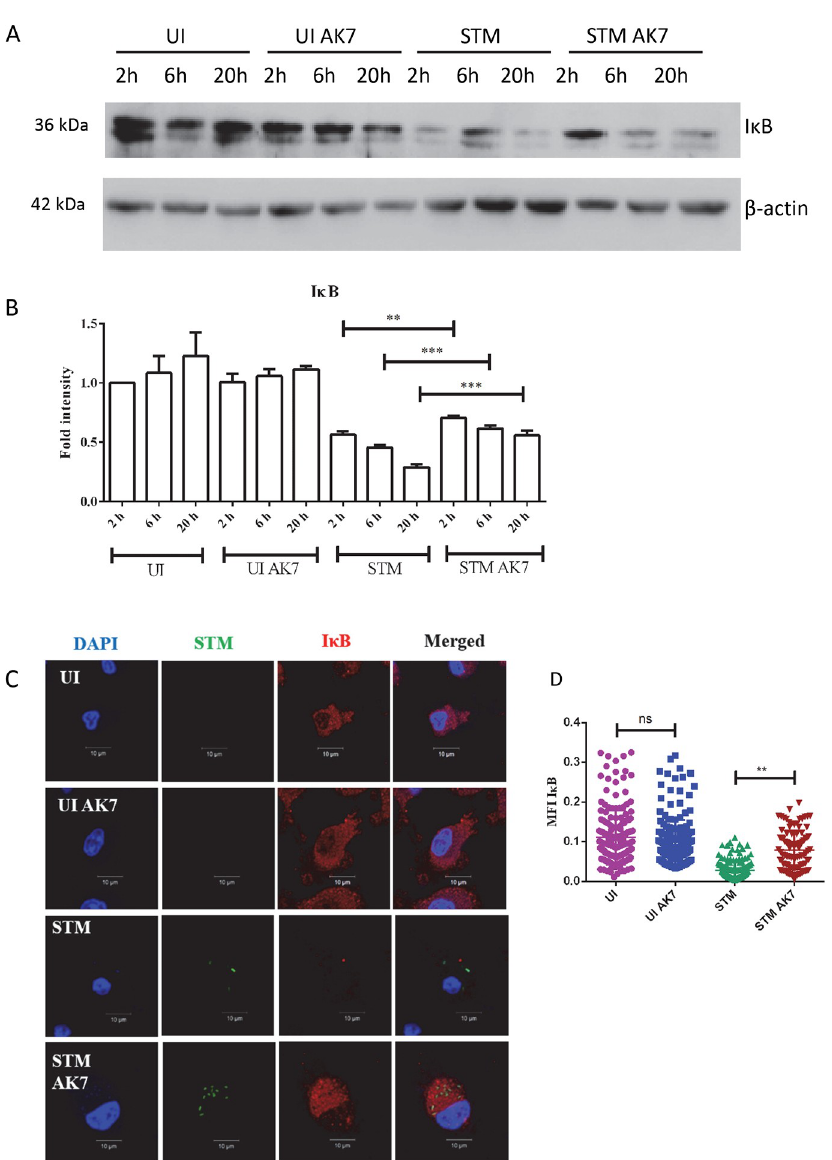
Fig 6. SIRT2 inhibition inhibits I κ B degradation. A. Representative immunoblot of I κ B in the presence and absence of SIRT2 inhibition at the indicated time point post infection. (UI- uninfected DCs, UI AK7- Uninfected DCs treated with 10 μ M AK7, STM- Salmonella Typhimurium infected DCs, STM AK7- Salmonella Typhimurium infected DCs treated with 10 μ M AK7). B. Densitometry analysis of I κ B immunoblot in the presence and absence of SIRT2 inhibition at the indicated time point post infection. (UI- uninfected DCs, UI AK7- Uninfected DCs treated with 10 μ M AK7, STM- Salmonella Typhimurium infected DCs, STM AK7- Salmonella Typhimurium infected DCs treated with 10 μ M AK7) (Data are presented as mean ± SEM of 3 independent experiments). C. Representative immunofluorescence image of I κ B in the presence and absence of SIRT2 inhibition at the indicated time point post infection. (UI- uninfected DCs, UI AK7- Uninfected DCs treated with 10 μ M AK7, STM- Salmonella Typhimurium infected DCs, STM AK7- Salmonella Typhimurium infected DCs treated with 10 μ M AK7) D. Mean Fluorescence Intensity (MFI) of immunofluorescence image of I κ B in the presence and absence of SIRT2 inhibition at the indicated time point post infection. (UI- uninfected DCs, UI AK7- Uninfected DCs treated with 10 μ M AK7, STM- Salmonella Typhimurium infected DCs, STM AK7- Salmonella Typhimurium infected DCs treated with 10 μ M AK7) (Red- I κ B, Green- Salmonella Typhimurium, Blue-DAPI) (n = 200) (unpaired two-tailed Student’s t- test, p- value, ��� < 0.0001, �� < 0.001, � <